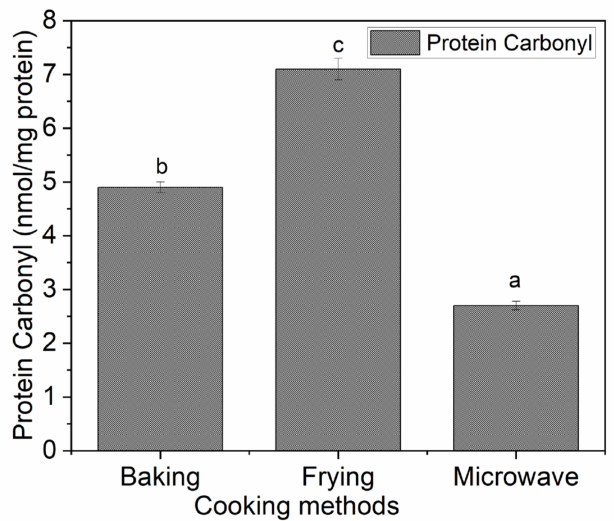
Figure 4. Protein carbonyl content of fish meat-based snacks prepared by different cooking methods. Reported values are mean of triplicate of each treatment and small letter over bar represent significant difference using one-way ANOVA and DMR’s test at a significance level of p <